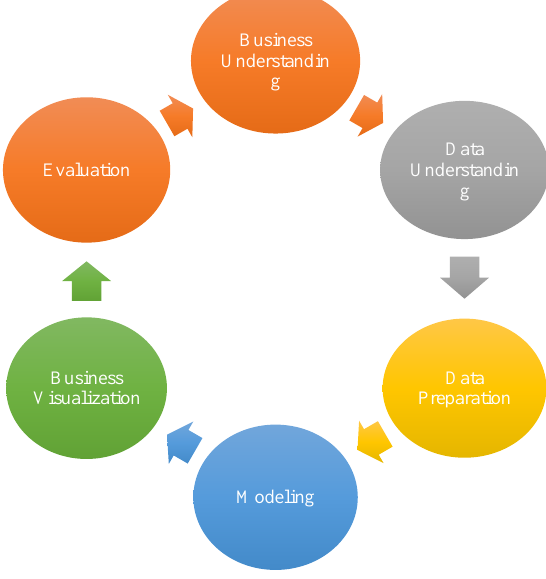
Figure 5. Customized CRISP-DM